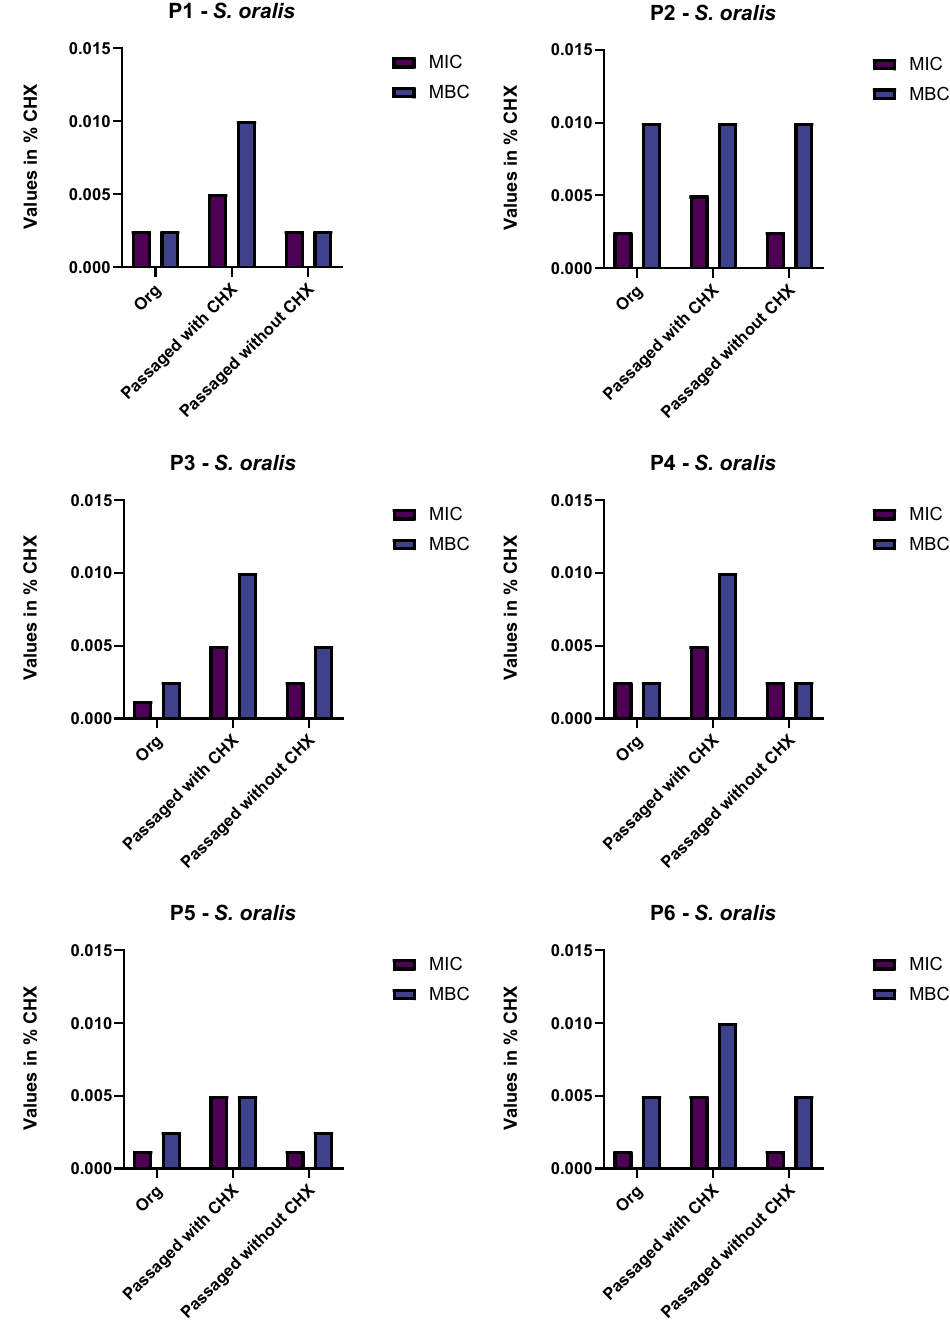
Figure 2. Minimum inhibitory concentration (MIC) and minimum bactericidal concentration (MBC) of the original S. oralis isolate and the isolates after passaging with and without the addition of chlorhexidine (CHX). Values are depicted in percent of CHX. P1–P6: Probands 1–6.